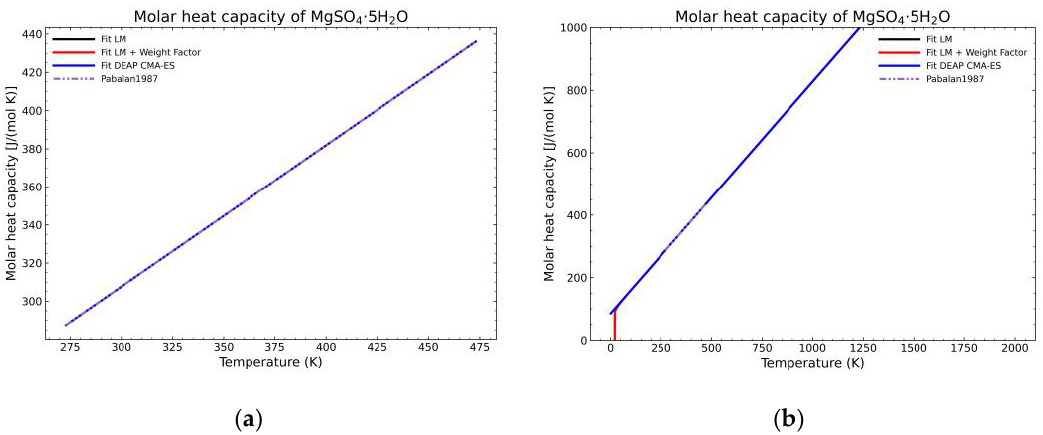
Figure 9. Comparison of the different fit results of MgSO 4 ·5H 2 O showing: ( a ) literature points region; ( b ) extended range until 2000 K.